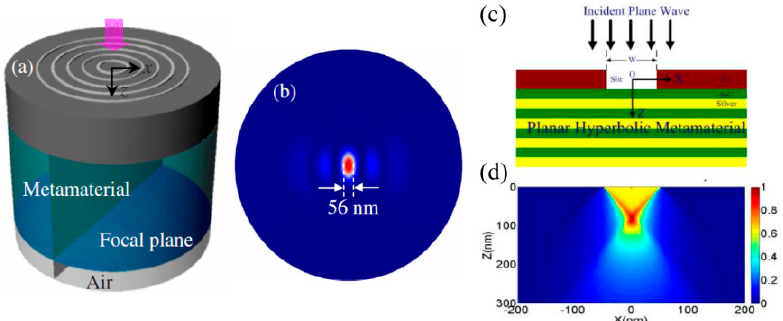
Figure 14. Nano spot achieved by focusing BPPs of hyperbolic metamaterial. ( a ) Metalens structure; ( b ) Simulation result of Metalens; ( c ) Plasmonic Fresnel plate structure; ( d ) Simulation result of plasmonic Fresnel plate. Reproduced from: (a,b), [75], Copyright © 2010, AIP; (c,d), [76], Copyright © 2010, OAS. Micromachines 2016 , 7, 118